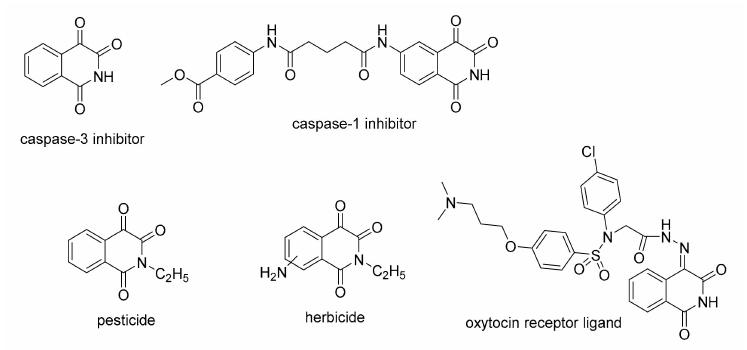
Figure 1. 1,3,4( 2H )-Isoquinolinetrione derivatives of biological